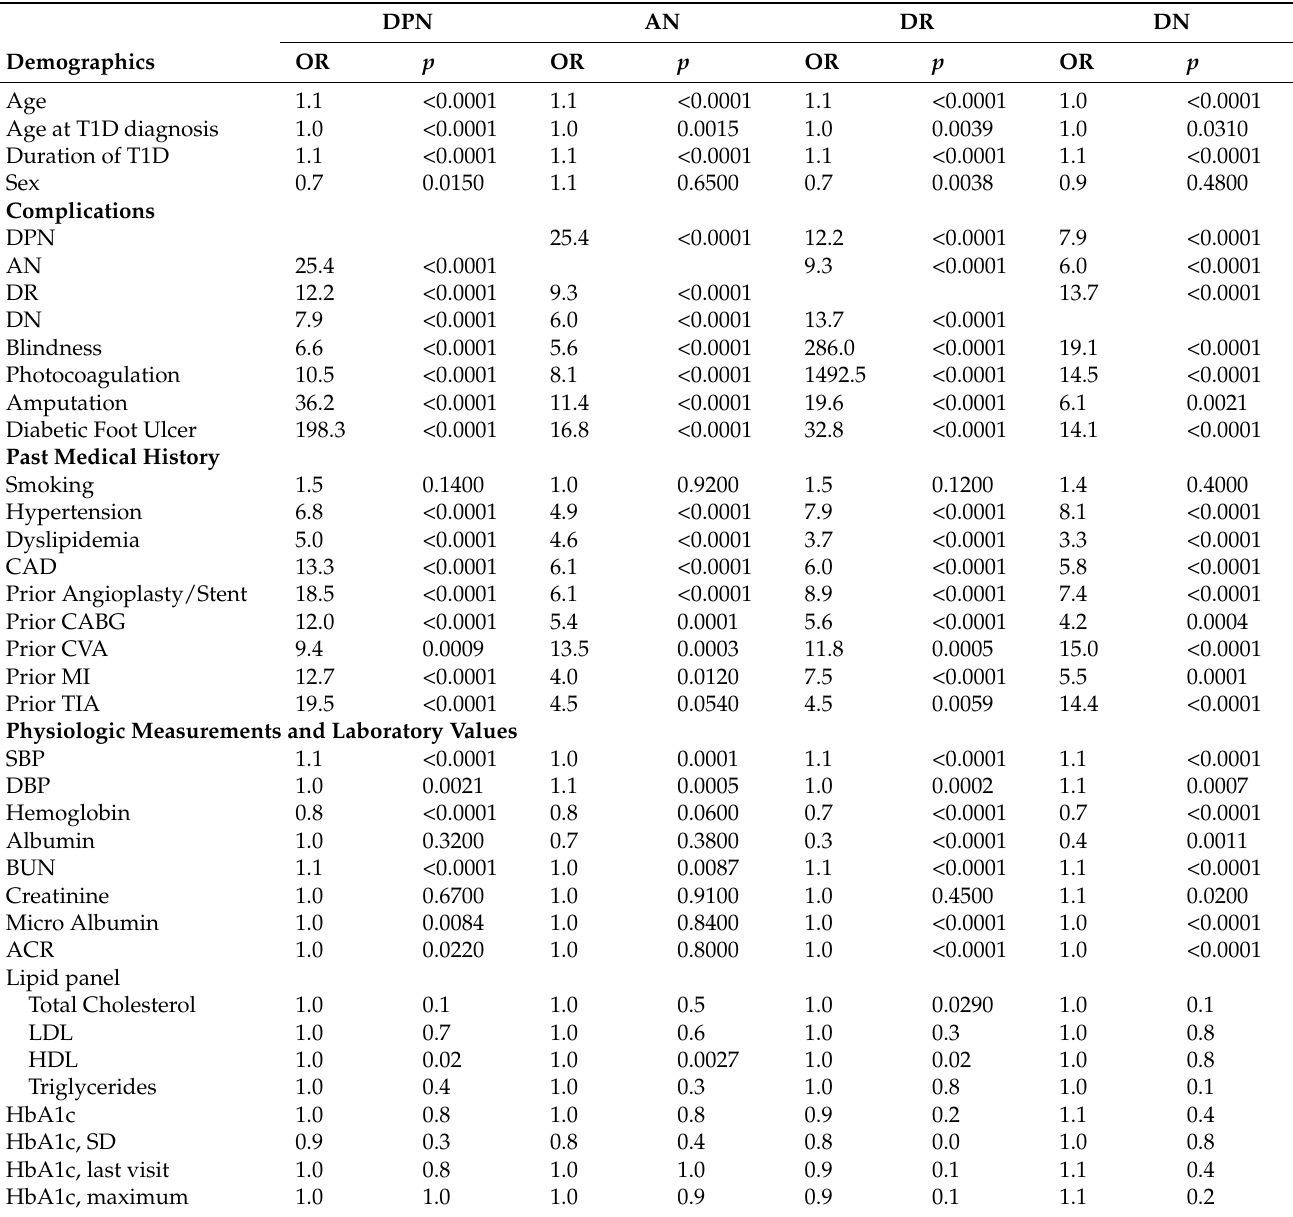
Table 2. Univariate association of clinical variables with diabetic